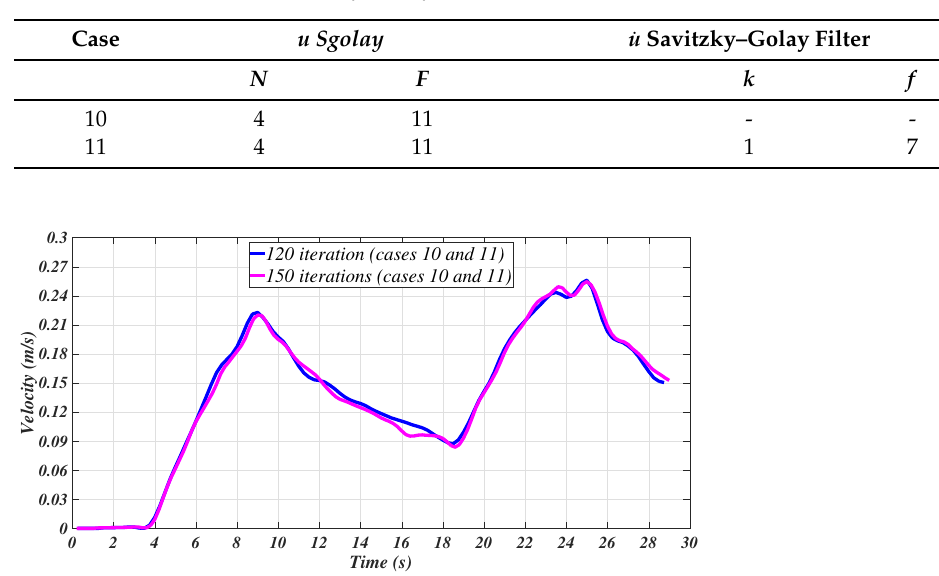
Figure 10. Comparative of the acceleration signals with double filter: case 8. Two supplementary cases were considered. Case 10 corresponds to the implemen- tation of the sgolay function to filter the velocity and compute the acceleration from the velocity data provided. Finally, case 11 corresponds to case 10 yet, with an additional Savitzky–Golay filter applied to the acceleration signal that was previously computed by the sgolay function. Table 3 introduces the parameters for these two cases. Figures 11 and 12 depict the corresponding results. Table 3. Parameters of the Savitzky–Golay method.